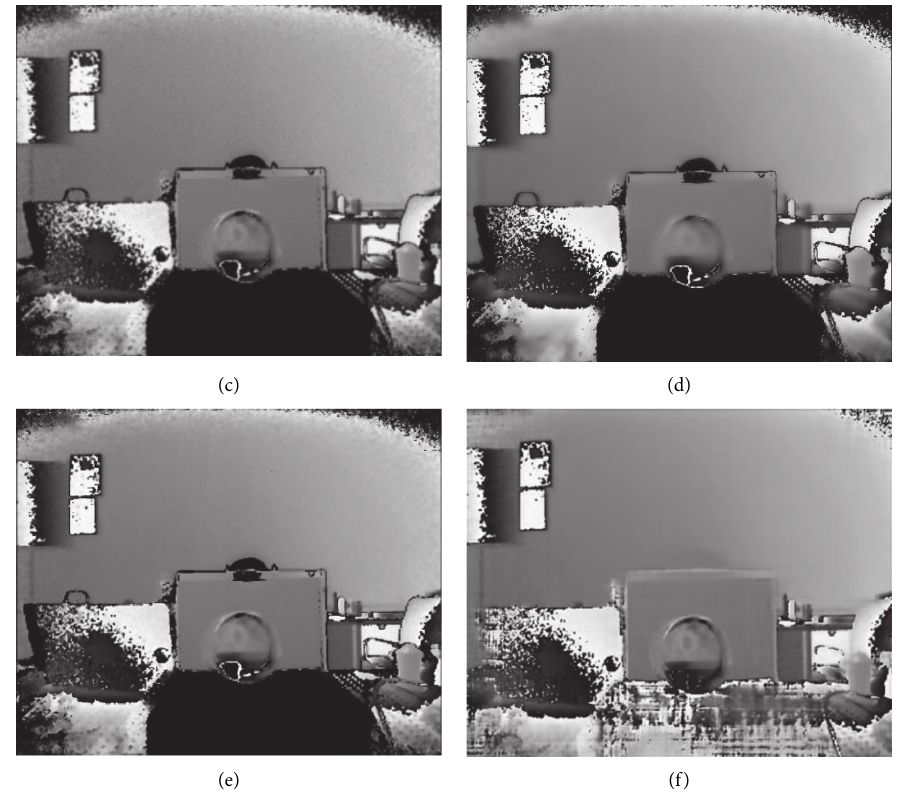
Figure 10: Comparison of various algorithms for hole patching. (a) Original depth map. (b) Median filtering method. (c) Gaussian filtering method. (d) Bilateral filtering method. (e) Joint bilateral filtering method. (f) Convolutional neural network